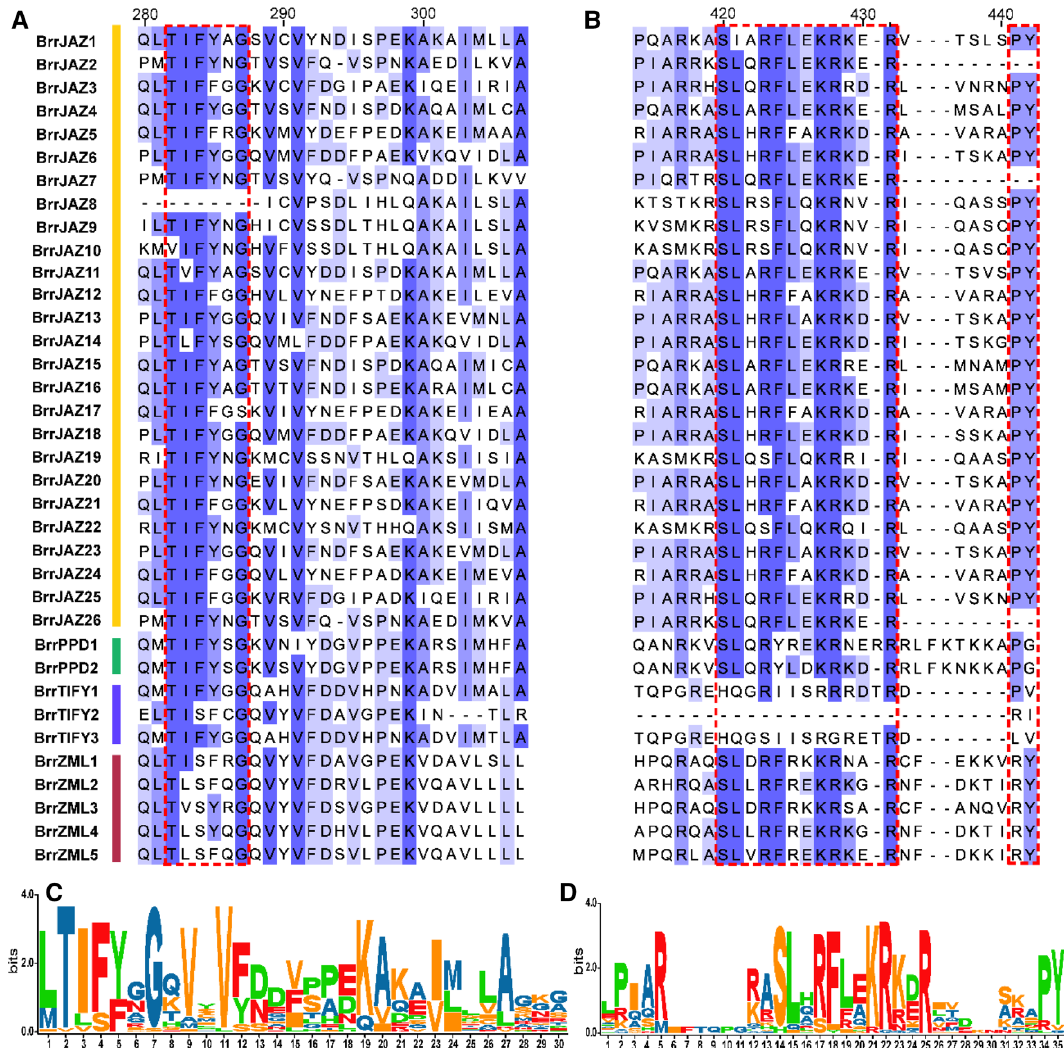
Figure 4. TIFY and JAZ domains in BrrJAZ proteins. ( A ) TIFY domain information. ( B ) JAZ domain information. ( C ) TIFY domain logos. ( D ) JAZ domain